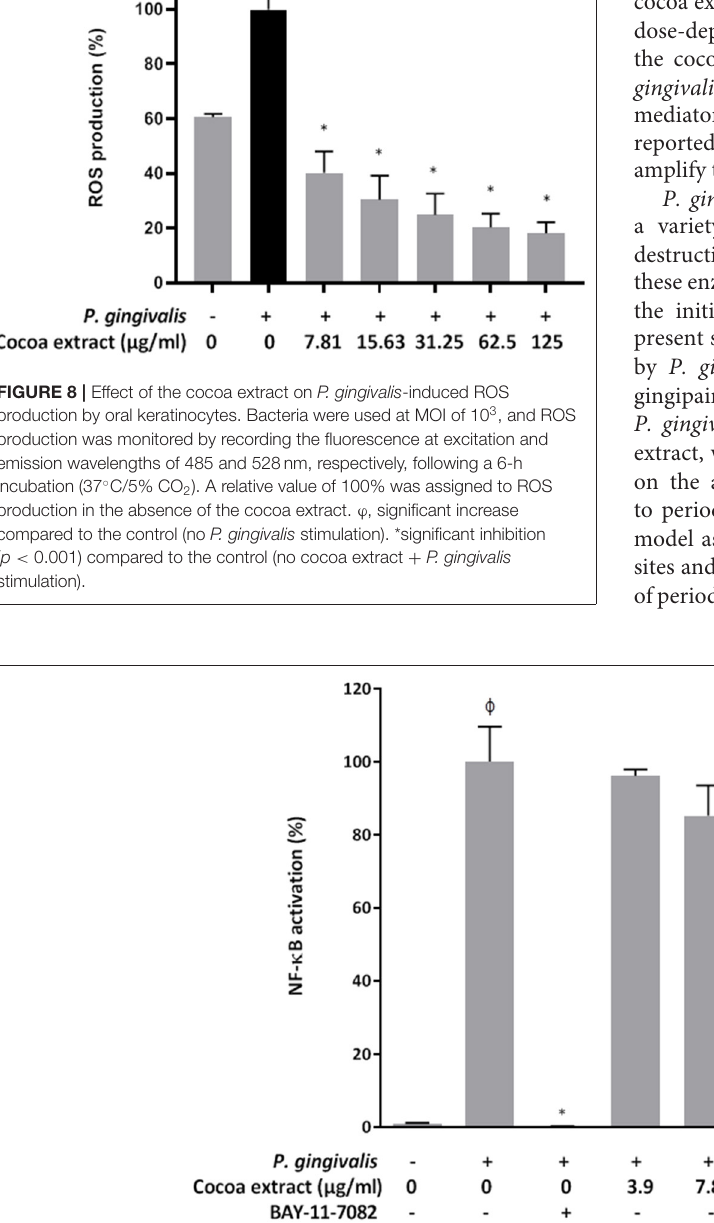
Frontiers in Oral Health |